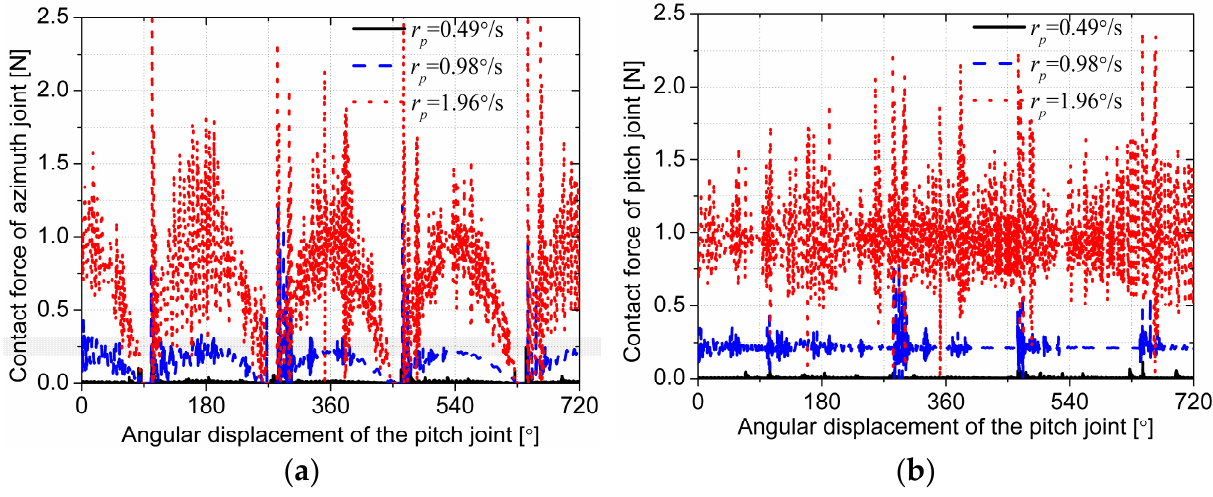
Figure 6. Radial contact force with a different rotational speed of pitch joint—( a ) radial contact force of azimuth joint output side and ( b ) radial contact force of pitch joint output side.